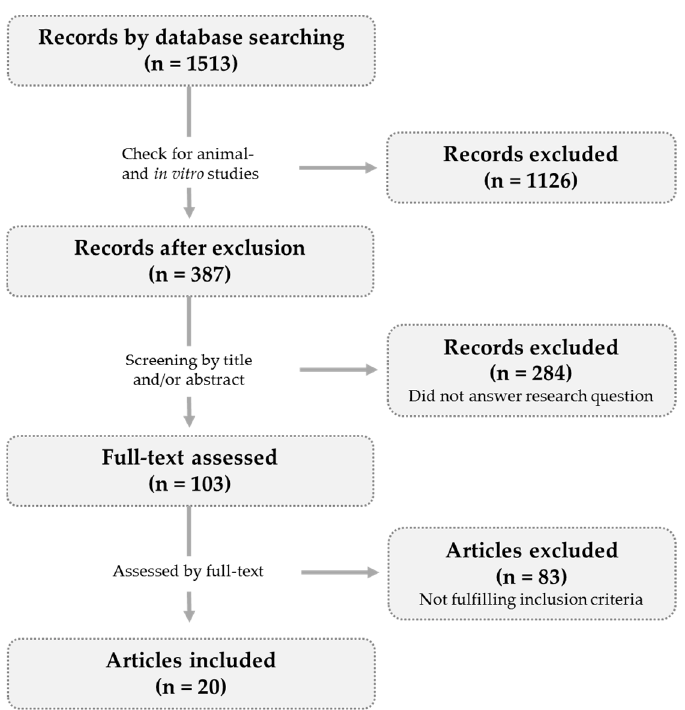
Figure 3. Study selection diagram. The literature search revealed 1513 hits (PubMed filters: publication date (from 01/01/2008 to 31/12/2018) and species (humans). After removal of further animal- and in vitro studies 387 records were screened. Full-text was assessed for 103 records and 83 articles did not meet the inclusion criteria. Twenty articles were included.